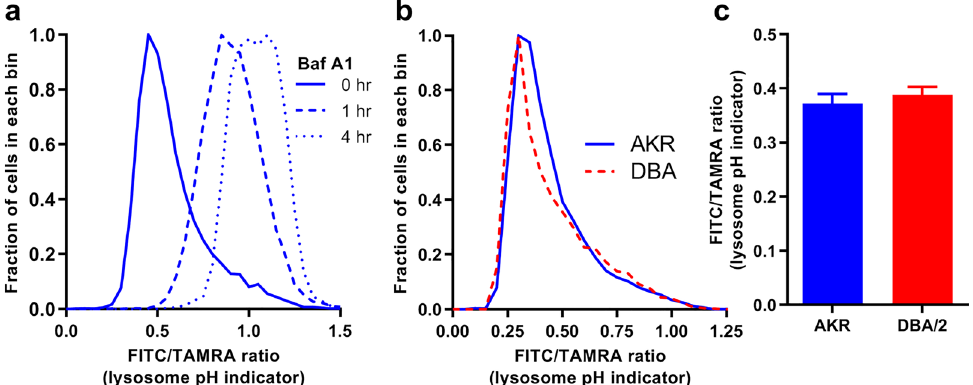
Figure 2. Unaltered lysosomal pH in DBA/2J versus AKR/J macrophages. ( a ) AKR BMDMs were incubated with 1 mg/mL FITC/TAMRA dextran for 18 h, and followed by a 4 h equilibration −/+ 10 µg Bafilomycin A1 added for the indicated times. Cells were analyzed by flow cytometry, demonstrating the effectiveness of this probe to assess lysosomal pH. ( b ) Lysosomal pH assay in AKR (solid blue line) and DBA/2 (dashed red line) BMDM was assessed by incubating cells with FITC/TAMRA dextran and analyzed by flow cytometry. ( c ) Analysis of lysosomal pH in AKR (blue bars) and DBA/2 (red bars) BMDM using median fluorescence intensity ratio (n = 3, not significant by two tailed t-test). Graphs prepared using GraphPad Prism software v9.0.0 (www. graph pad.